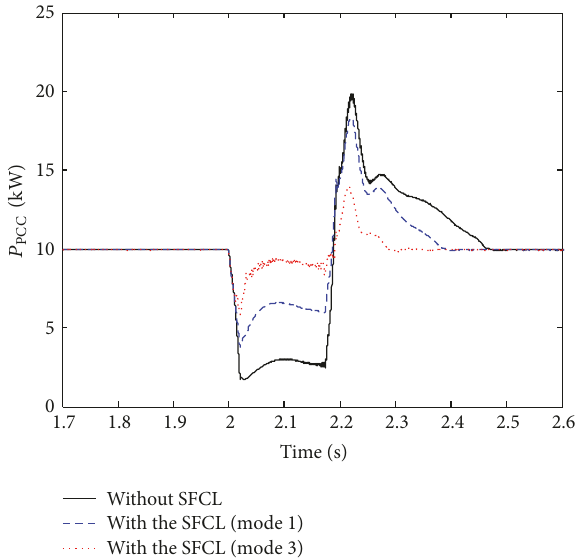
Figure 15: Effects of the active SFCL on the PCC power under the symmetrical fault.